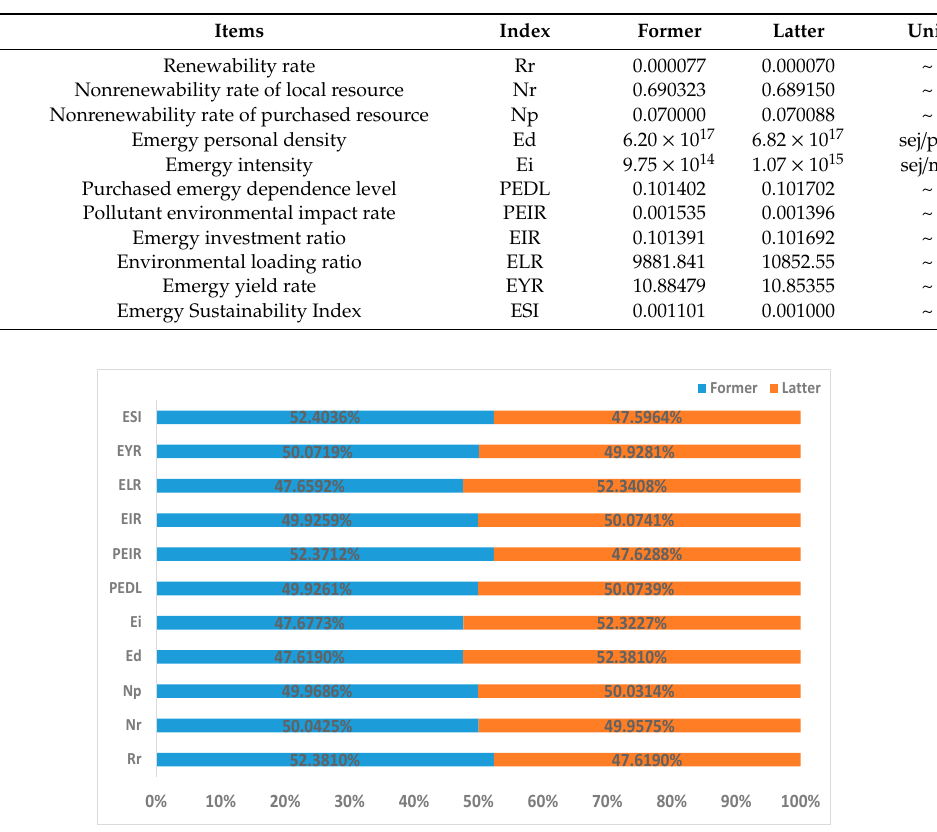
Figure 5. The indicator changes between former and latter. Table 13 demonstrates sensitivity analysis situations in the hypothesis. Within − 10% changes in the three sections, it can be concluded that the nonrenewable resources have the most significant fluctuation (6.903%), followed by energy (2.352%) and purchased resources (0.700%). The reason for the tendency is that nonrenewable resources play a significant consequence, more critical than others, and this can be known from the emergy contribution ratio, accounting for 69.1% of total emergy in the evaluated system. The same explanations can be for purchased resources and energy. The higher the emergy ratio, the greater the sensitivity results. This result explains that the staple emergy contributor exerts the foremost impact on sensitivity analysis. Sensitivity analysis of all indicators has been illustrated in Figures 4 and 5 for Rr (4.7619%), Nr (0.0850%), Np ( − 0.0628%), Ed ( − 4.7619%), ELR ( − 4.6816%), PEDL ( − 0.1477%), PEIR (4.7424%), EIR ( − 0.1482%), ELR ( − 4.6816%), EYR (0.1437%), ESI (4.8072%). It is found that ESI (4.8072%) has the biggest impact, followed by Rr (4.7619%), Ed ( − 4.7619%), PEIR (4.7424%), ELR ( − 4.6816%), and ELR ( − 4.6816%). 3.6. Industrial Pollutant Analysis In the new sewage treatment plant system, there are three main types of pollutant emissions in Table 8, including exhaust gas, wastewater, and solid waste. Specific details have been displayed in the note of Table 10. According to Table 10, wastewater is the major contributor and accounts for 0.15% of the entire emergy and almost 100% of the industrial pollutant emergy. Therein, exhaust gas and wastewater have virtually no impact on the system. It is clear that sludge treatment technology (Figure 3) is feasible and has a better effect than wastewater treatment technology (Figure 1).